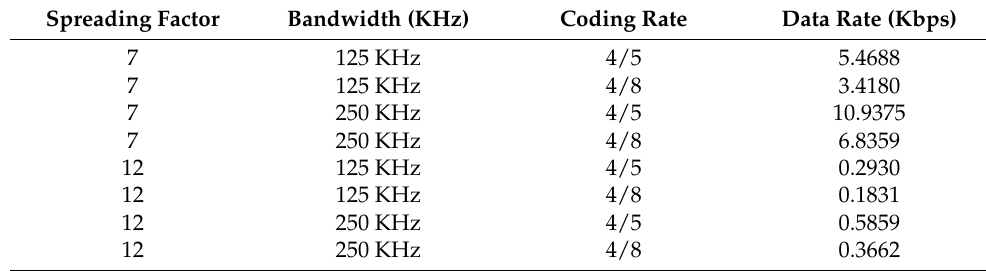
Figure 10. Simulated data transmission rate measurements. (a) Results when setting SF to 7 and changing CR and BW. (b) Results when setting BW to 125 KHz and changing CR and SF. (c) Results when setting CR to 4/5 and changing BW and SF. Table 3. A summary comparison of data rate as a function of SF, bandwidth and CR.